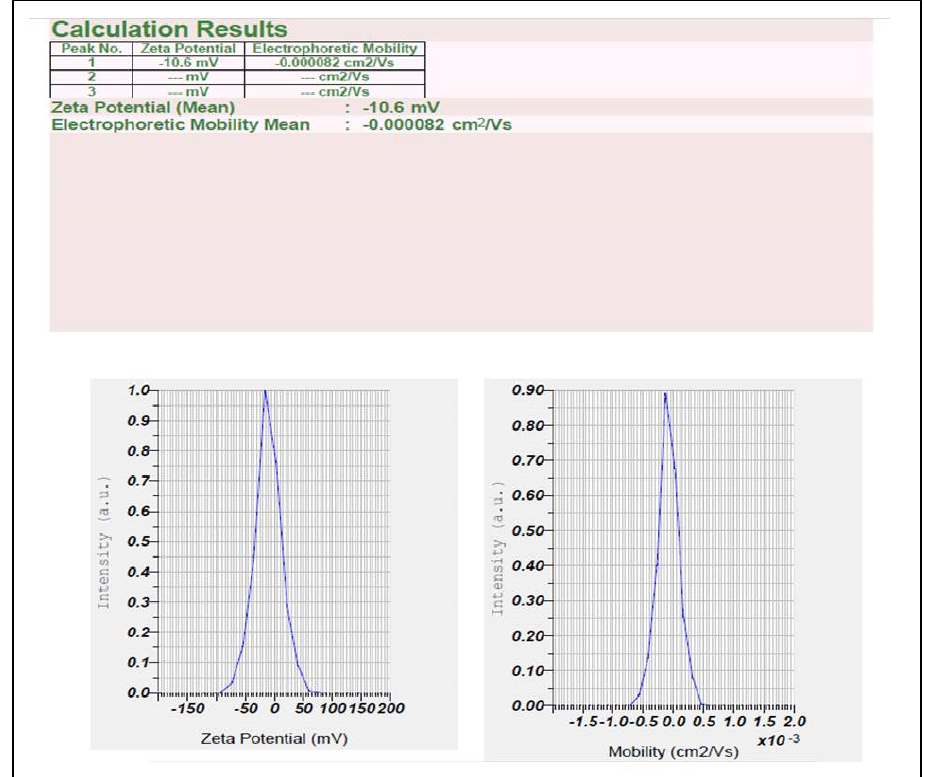
Figure 6. Zeta potential distribution of V. leucoxylon FeNPs.